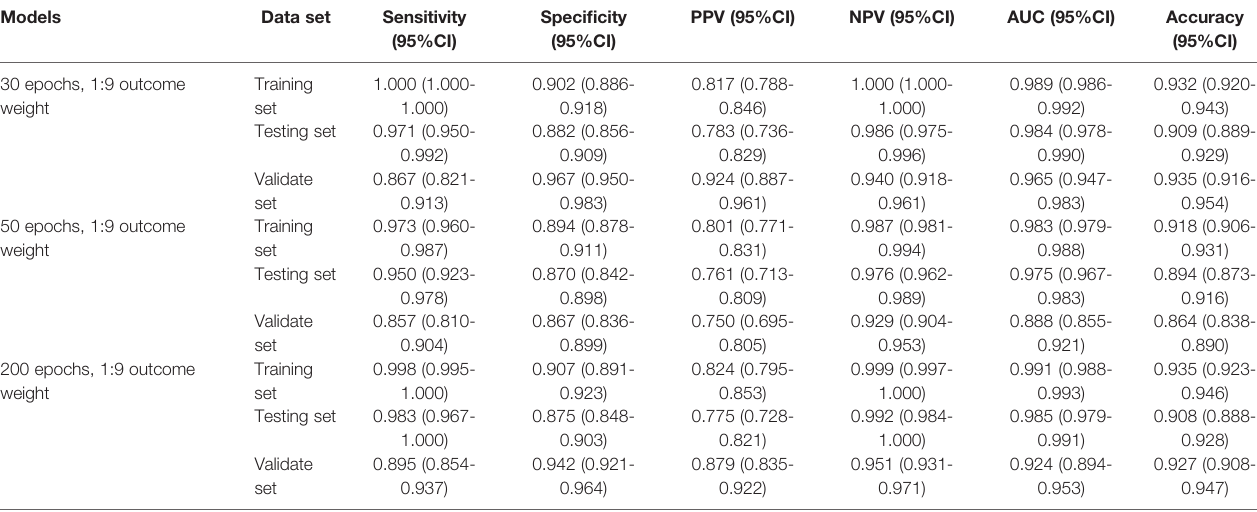
TABLE 2 | The performances of the MDS two-classi fi cation model with different epochs. Models